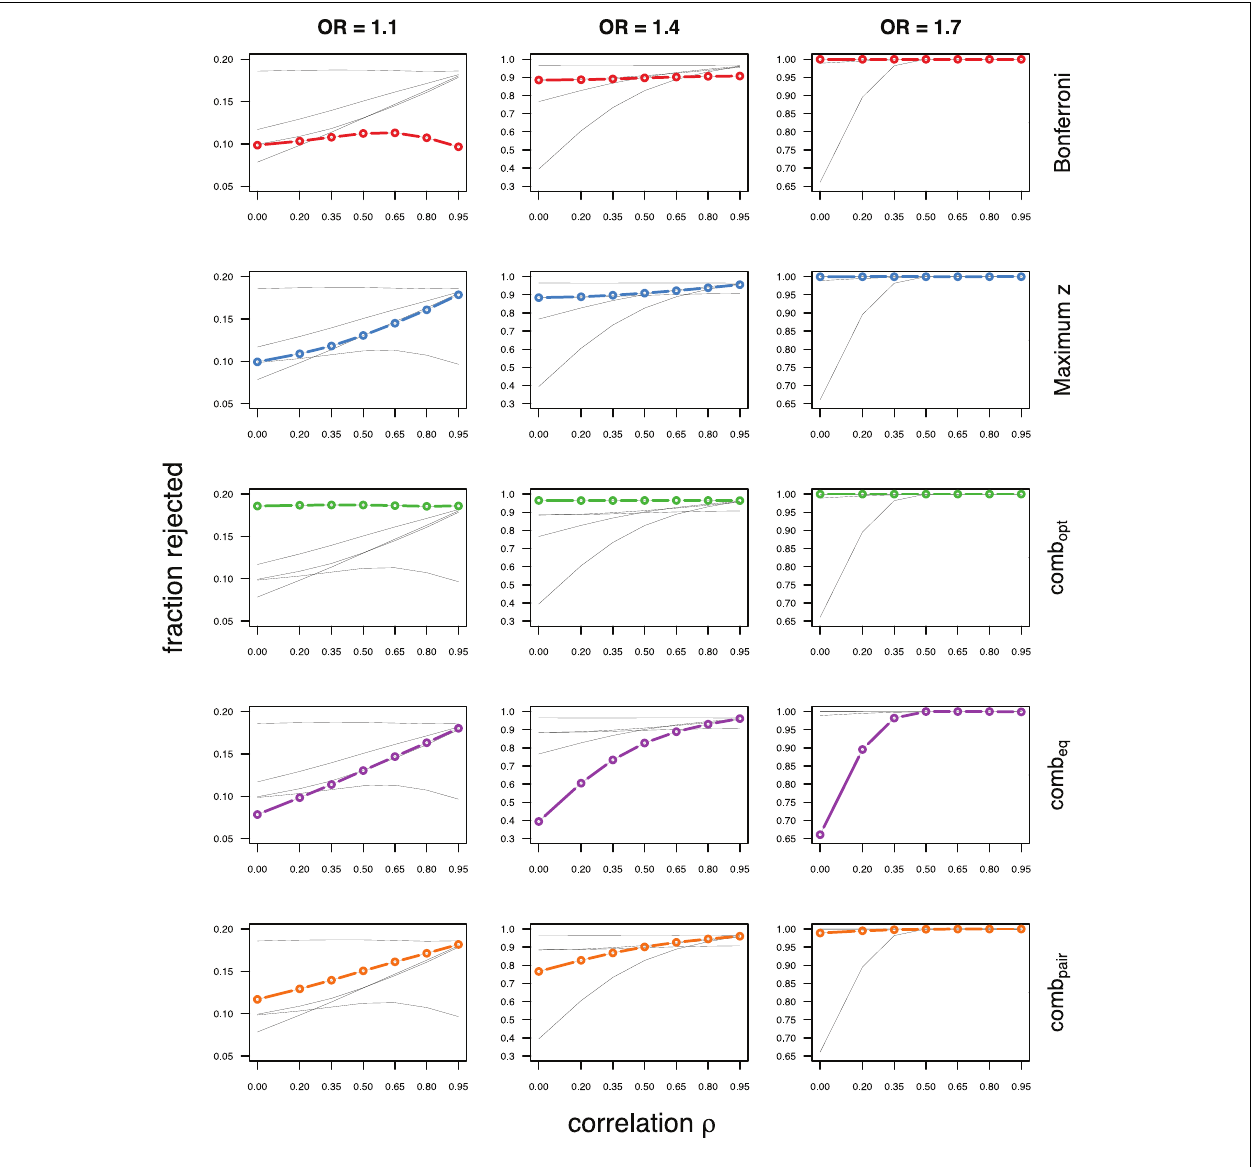
FIGURE 3 | Comparing analytic strategies in the setting with compound symmetry correlation structures, assuming equal minor allele frequencies of 25% in a block of 5 markers. The fraction of rejected null hypotheses of no association (power, y-axis) in 50,000